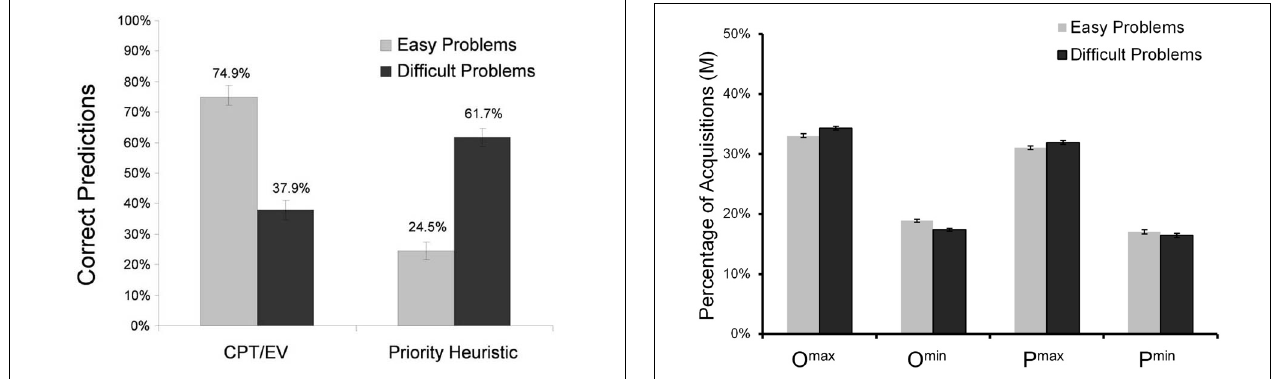
FIGURE 3 | Correct predictions of the individual choices in Experiment 2. CPT, cumulative prospect theory, EV, expected value theory. The error bars represent standard errors of the mean. standard errors of the